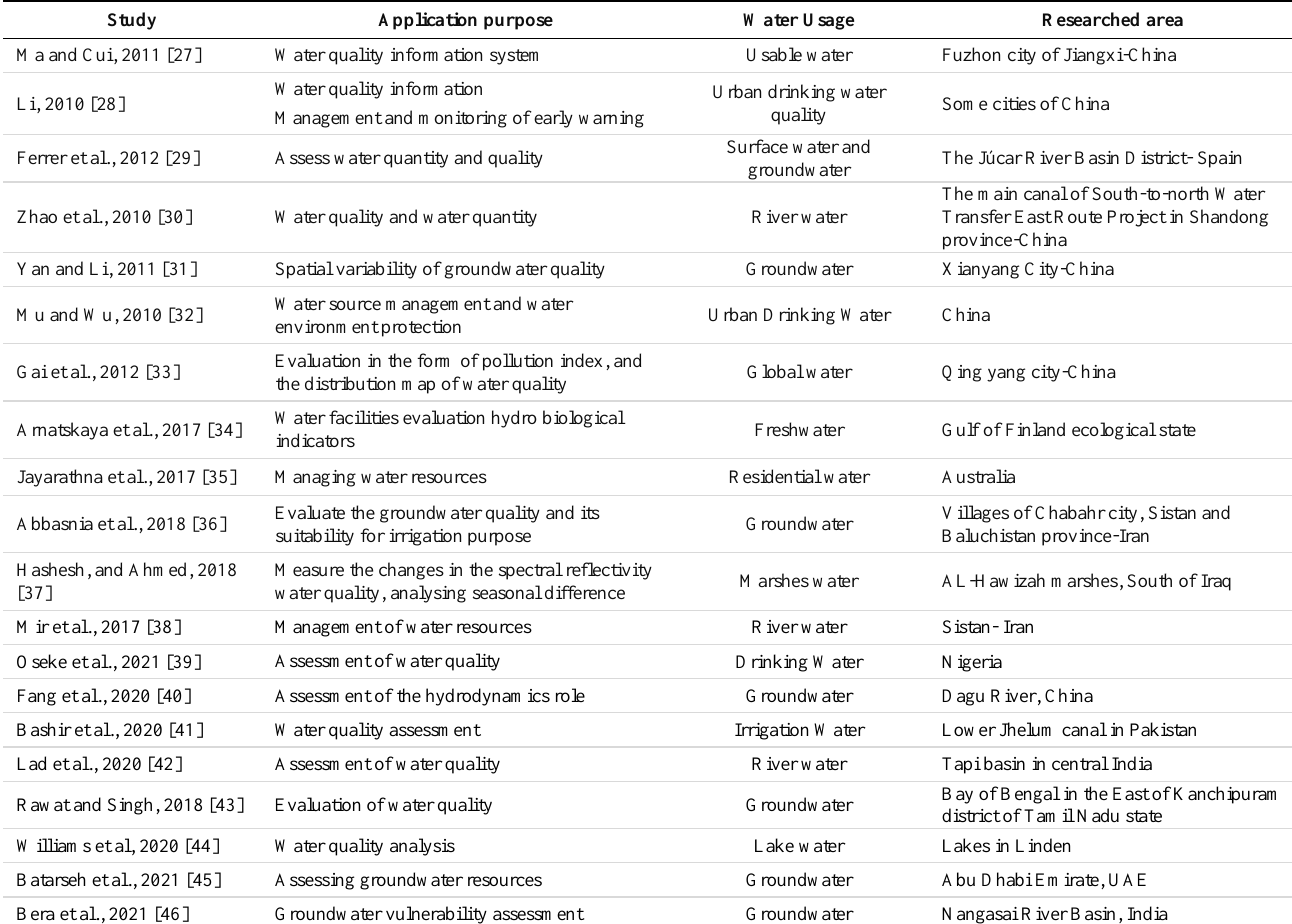
Table 1. The literature in GIS for water quality for the period between 2010 and